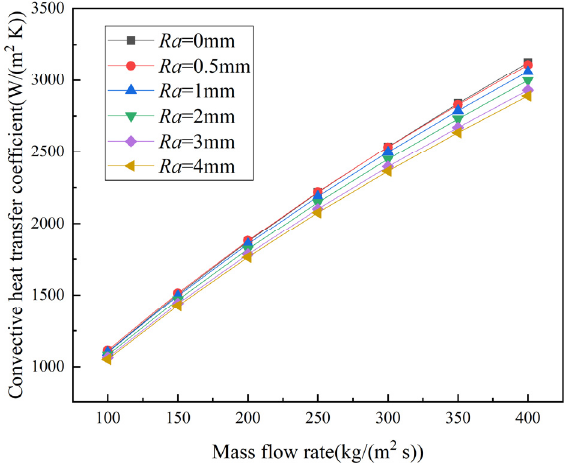
Figure 12. Convective heat transfer coefficient values of PCHEs at different mass flow rates for different curvature radii of inserted arc segments.